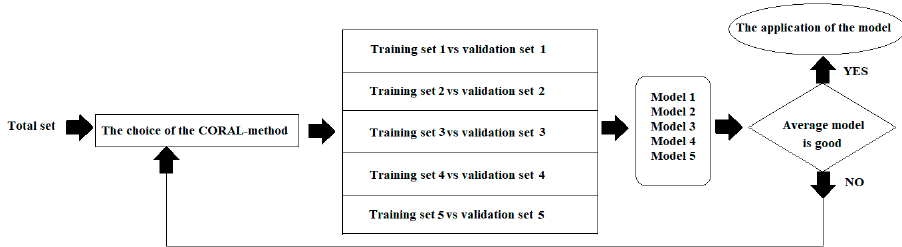
Figure 1. The general scheme of the study using CORAL